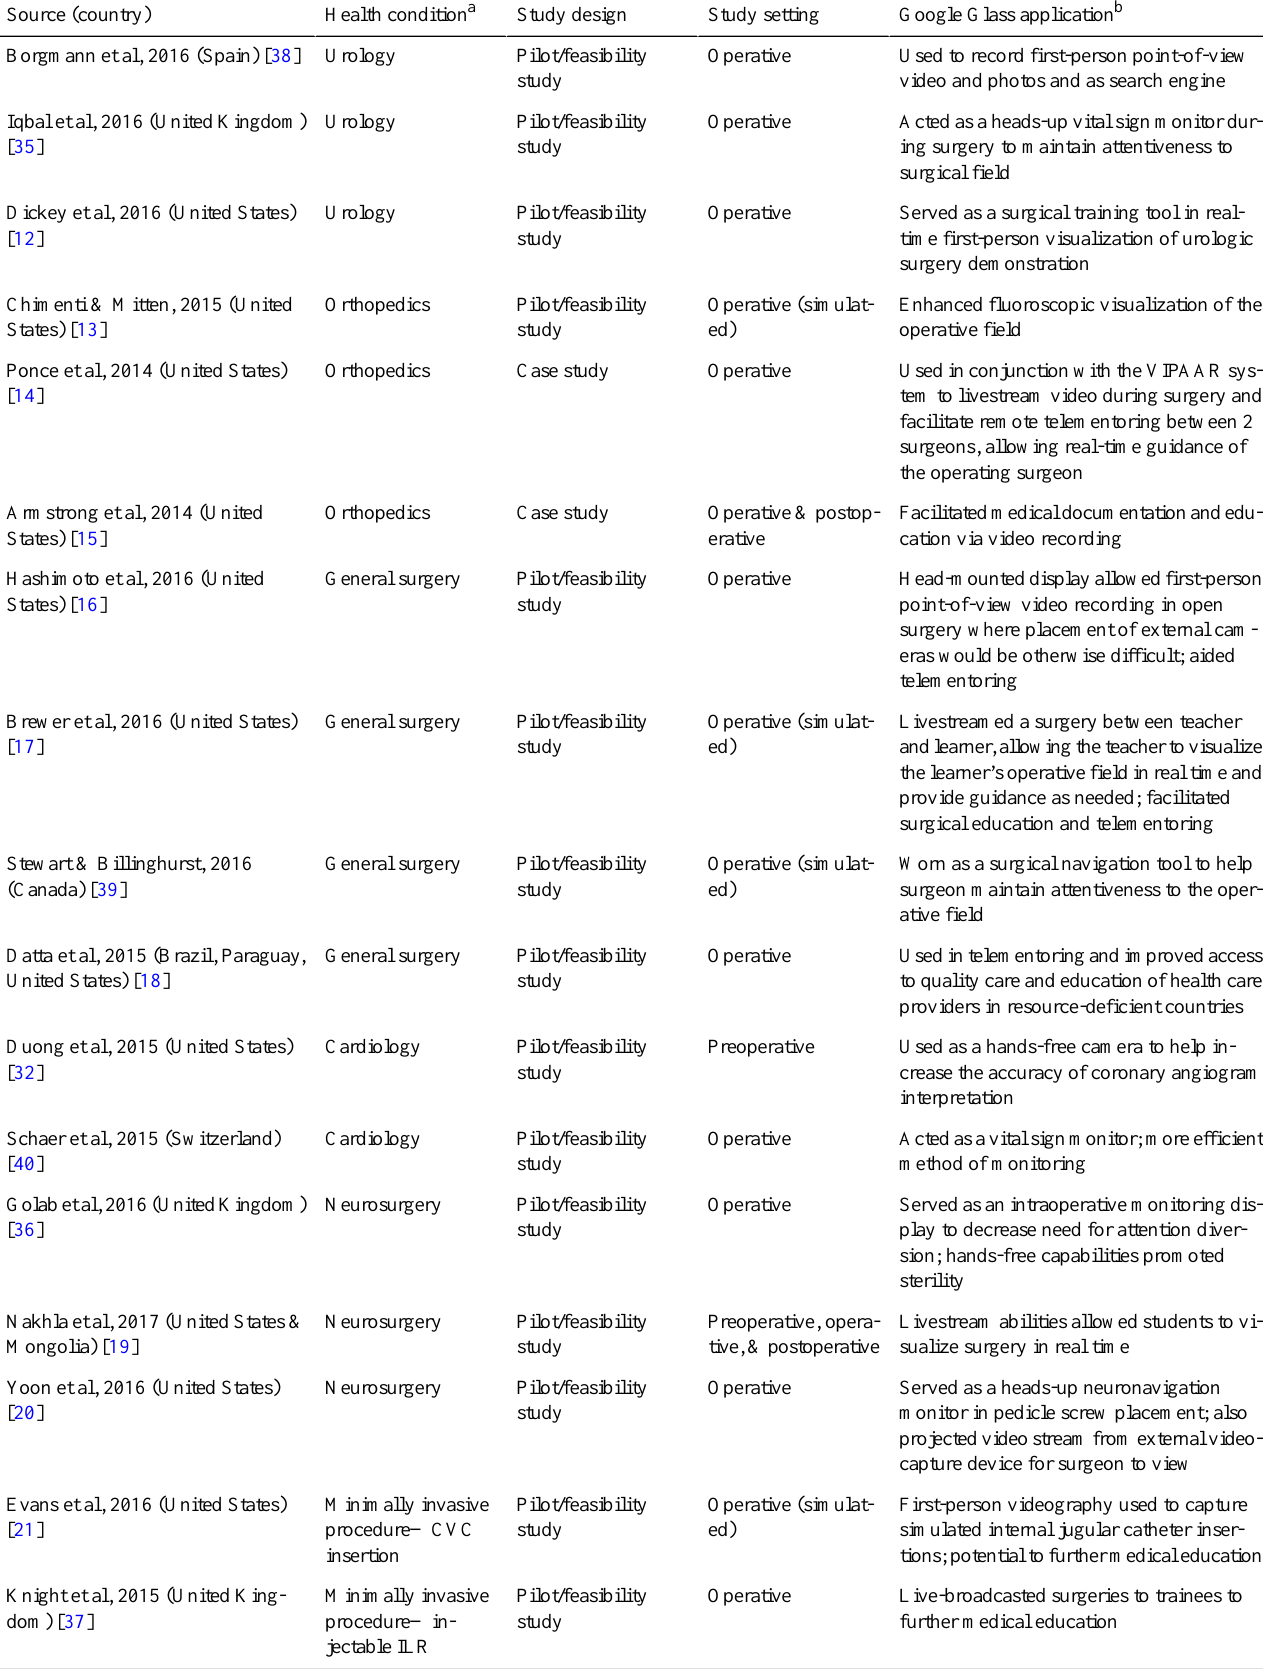
Table 1. Summary of the included studies evaluating the application of Google Glass to surgical medical